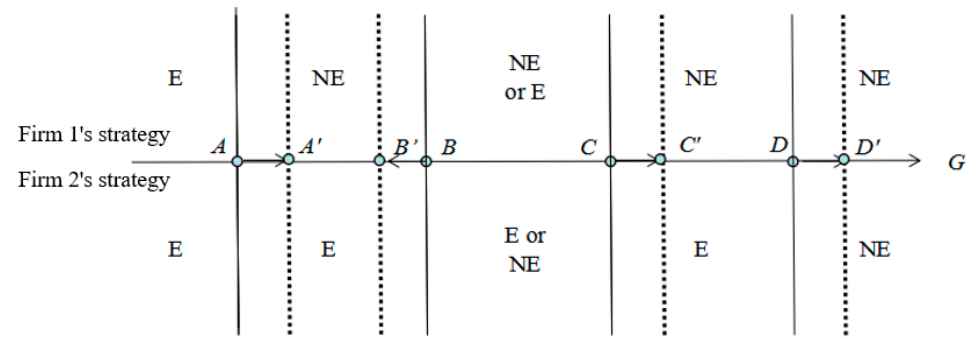
Figure 2. Changes in the export decisions due to a lower c when either c < a and λ < 1 . 2